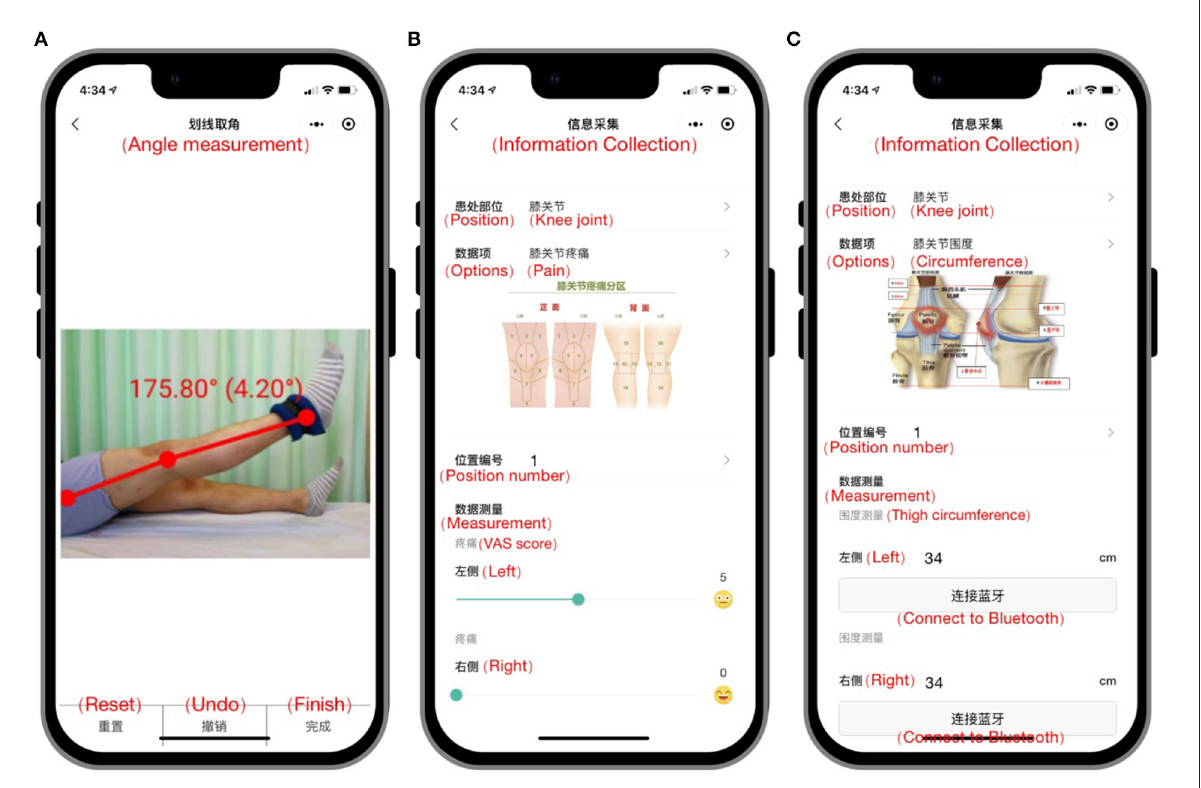
FIGURE2 Data collection interface of the “Rhabilitation Cloud Platform.” (A) After the patient uploads the photo, the platform can automatically measure the ROM; (B) Patients can record the VAS score of knee flexion pain through the platform; (C) Patients can record the thigh circumference through the